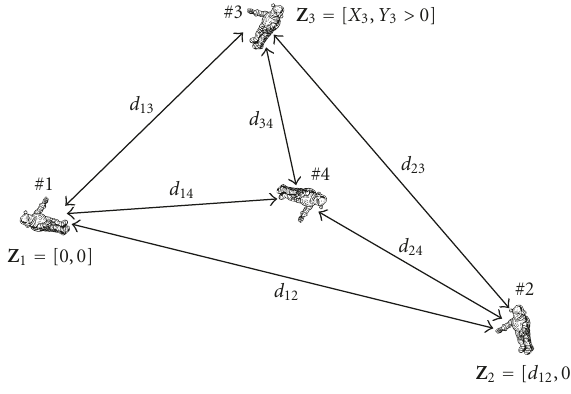
Figure 2: Pivot robots selection with M =